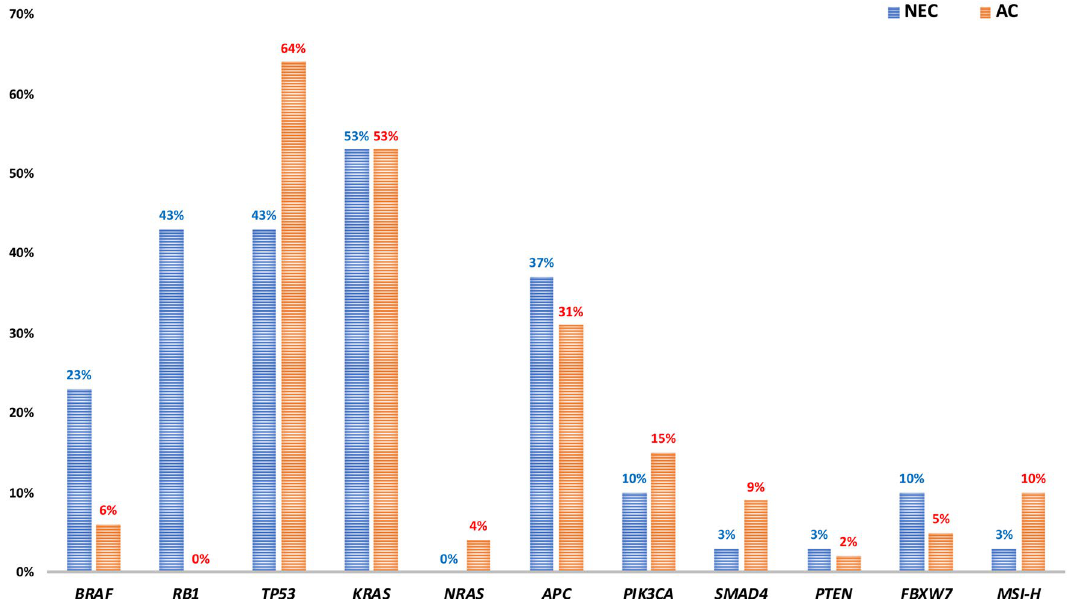
Figure 3. Bar graph depicting frequencies of somatic mutations in colorectal neuroendocrine carcinomas (NECs) and adenocarcinomas (ACs) after matching tumour site. There is a significant difference in frequencies of BRAF mutations between two groups ( p =